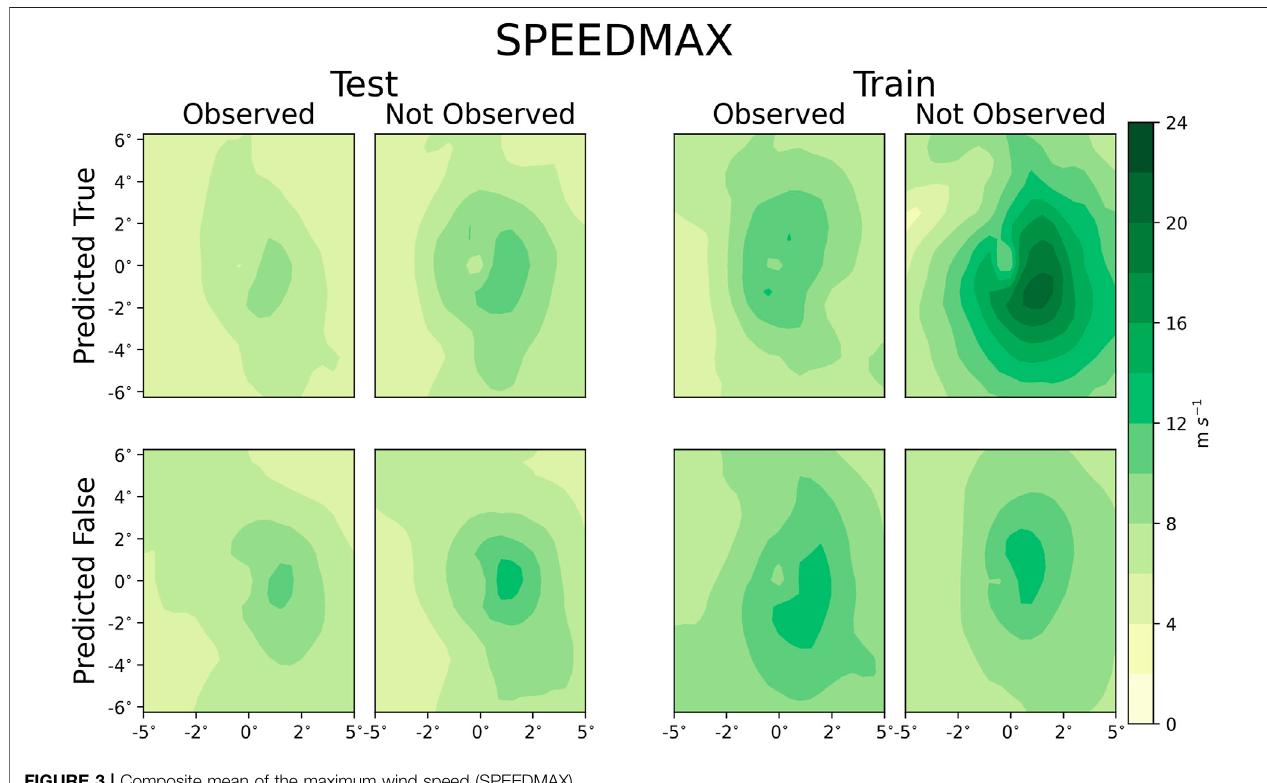
FIGURE 3 | Composite mean of the maximum wind speed (SPEEDMAX).